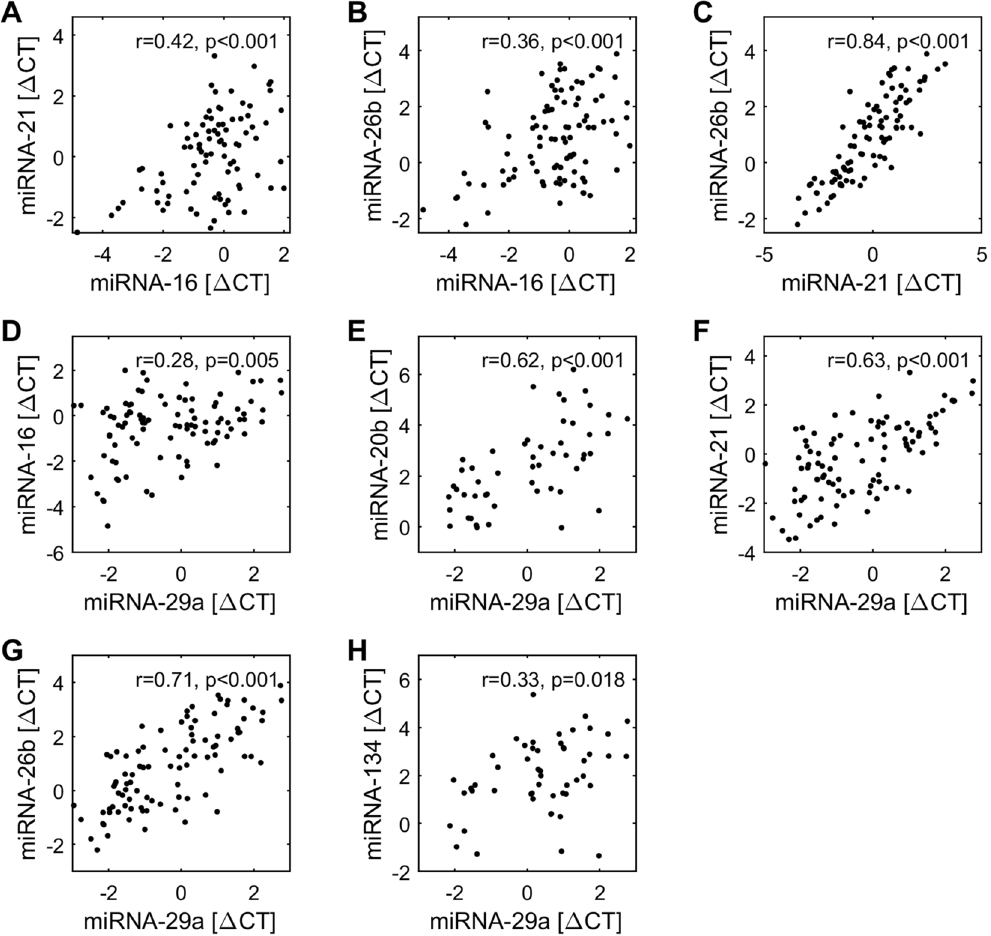
Figure 5. Correlations among miRNAs. All correlations were calculated using Spearman rank correlation procedure. p < 0.05 as considered significant, p < 0.10 was considered showing tendency towards